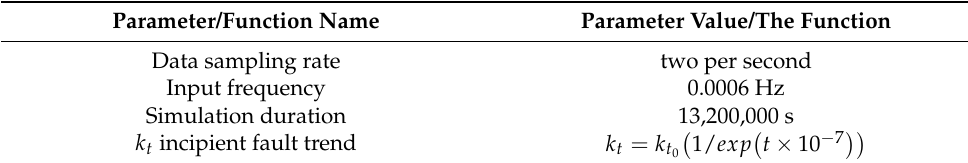
Table 10. Parameters for the months span simulation.